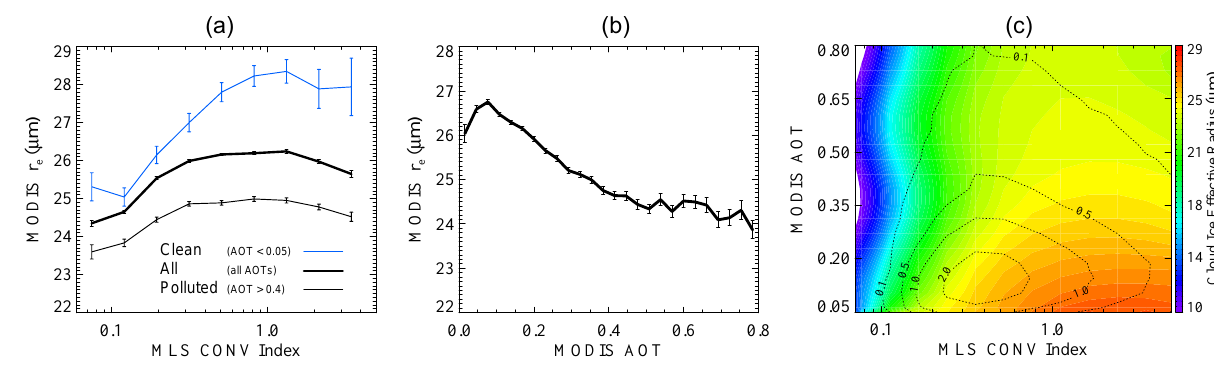
Fig. 2. (a): MODIS measured ice cloud r e binned according to CONV, based on MLS IWC at 215hPa. The thick black curve is the average r e as a function of CONV using all values of AOT. The blue curve is for data with AOT < 0.05 and the thin black curve is for data in heavily polluted environment with AOT > 0.4. (b): MODIS r e binned according to the MODIS AOT measurements. (c): A Bi-Variate Composite (BVC) plot of the r e -CONV-AOT relation, in which the MODIS r e data are binned according to both MLS IWC and MODIS AOT. The dotted-lines are the occurrence frequency for each CONV-AOT bin. All collocated MODIS and MLS measurements from August 2004 to July 2008 between 50 ◦ S to 50 ◦ N are used for the plot. The error bars in (a) and (b) denote the standard errors ( σ/